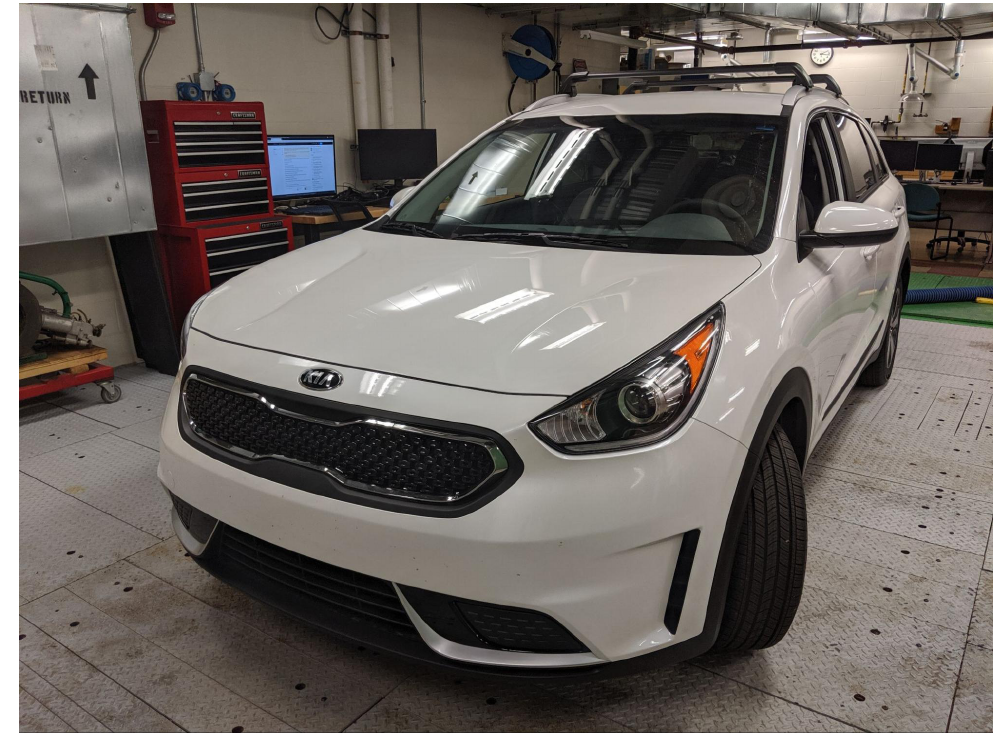
Figure 1. Stock 2019 Kia Niro, DBW compatible, as purchased from a local Kia